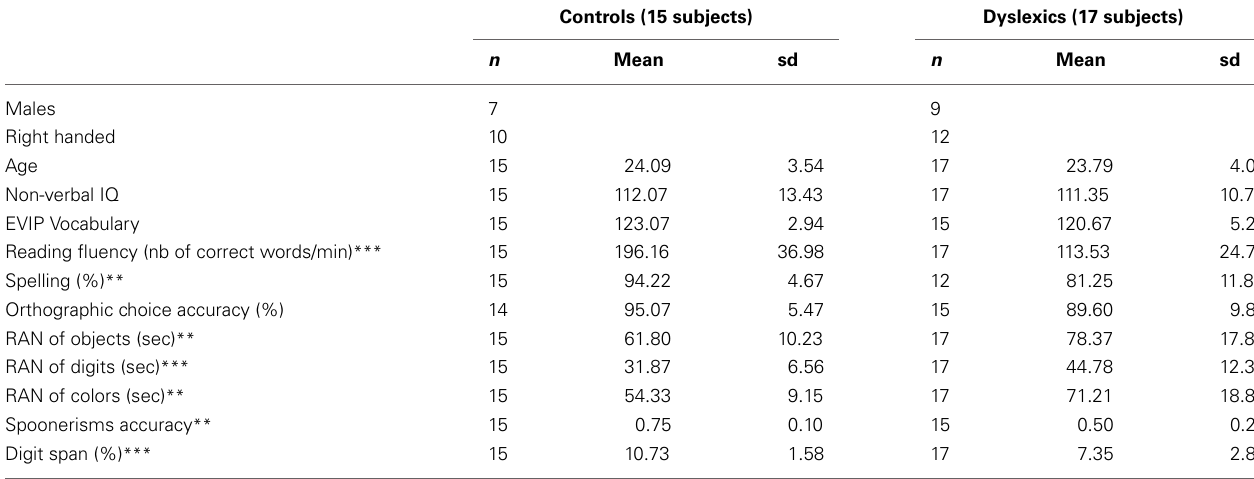
Table 1 | Summary of behavioral